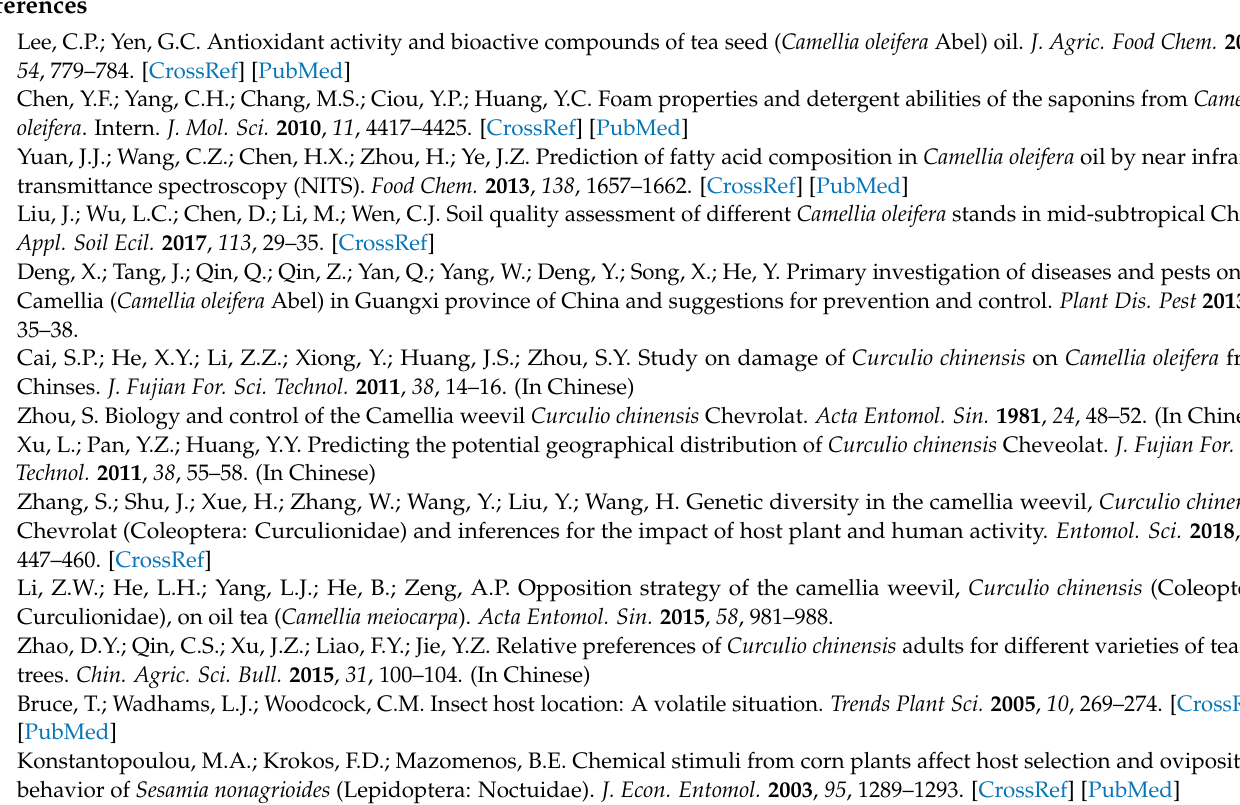
Table S1: Source information of selected standard